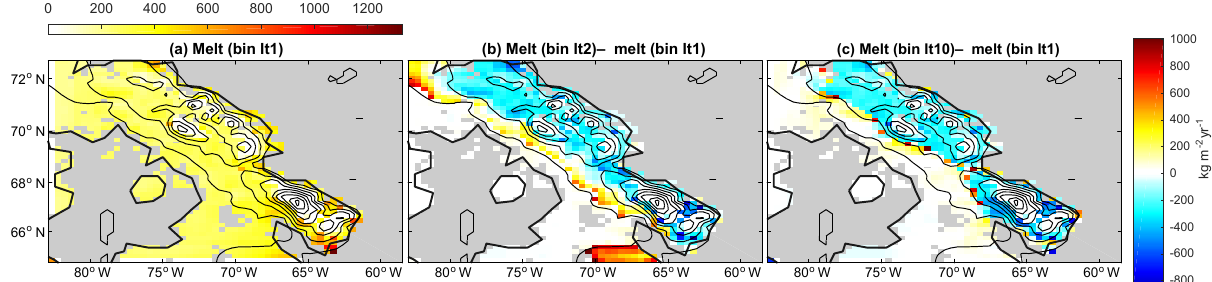
Figure 5. Melting in WRF in select iterations: (a) melting in the Iteration 1 WRF run. Differences in melting between Iteration 1 and the (b) second and (c) last